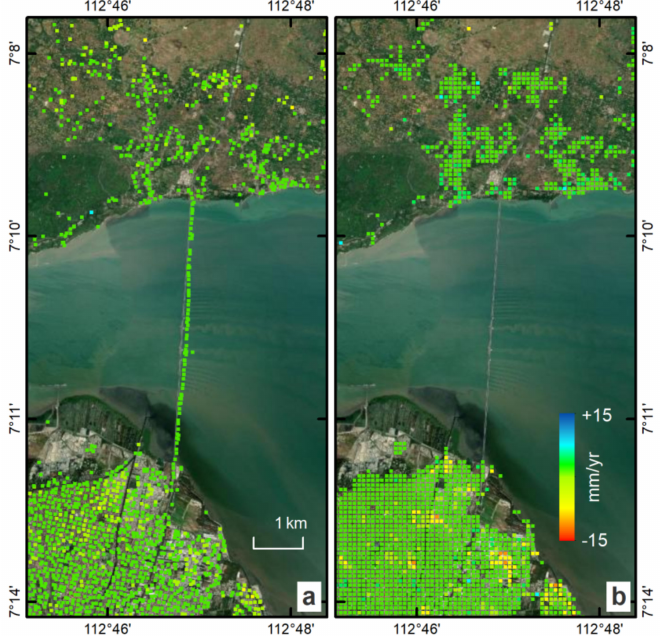
Figure 12. Sentinel-1 LoS displacement rates (2015–2020) over Surabaya (Indonesia) for points detected by ( a ) SNAPPING PSI Med and ( b ) P-SBAS services. The additional points detected by each service are shown in the supplementary material (Figure S2). Please note that datasets do not share common references (see manuscript for details). Symbol priority for the visualization (overlap of neighboring points), is given to those with higher subsidence rates. Contains modified Copernicus Sentinel-1 mission data (2015–2020), processed by AUTh on GEP.